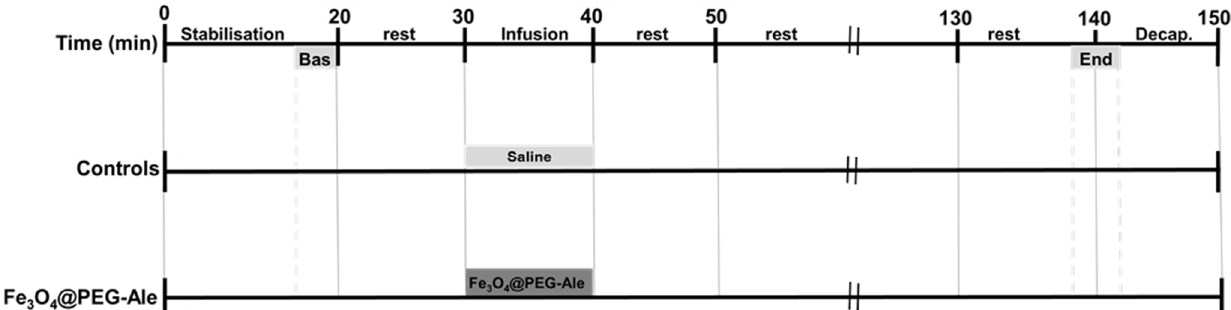
Figure 2. Time course of the experimental protocol. Basal recordings of blood pressure and heart rate were determined at the beginning (Bas) and at the end of the experiment as the average values of ~120-s time periods between 16–20 min and 138–142 min of the experiment. Then, the rats were decapitated (Decap.). Bas, baseline; Fe 3 O 4 @PEG-Ale, Fe 3 O 4 @PEG- alendronate nanoparticles.